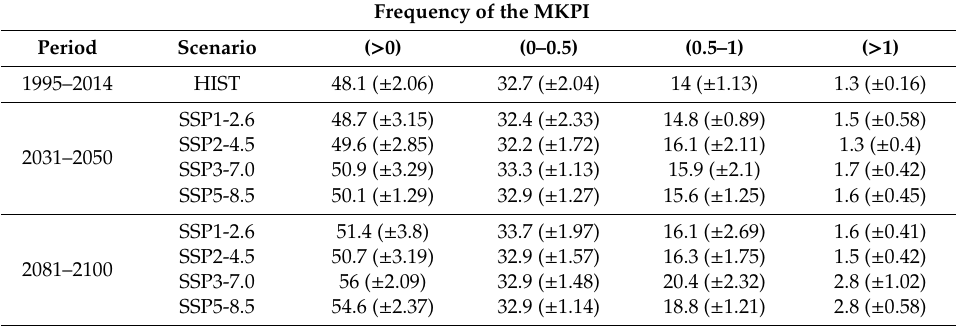
Table 3. Change in frequency for di ff erent winter MKPI values. The columns show historical (1995–2014), near-term future (2031–2050), and long-term future (2081–2100) climates and standard deviation (in parentheses) of the frequency in the interrelationships (days per season),